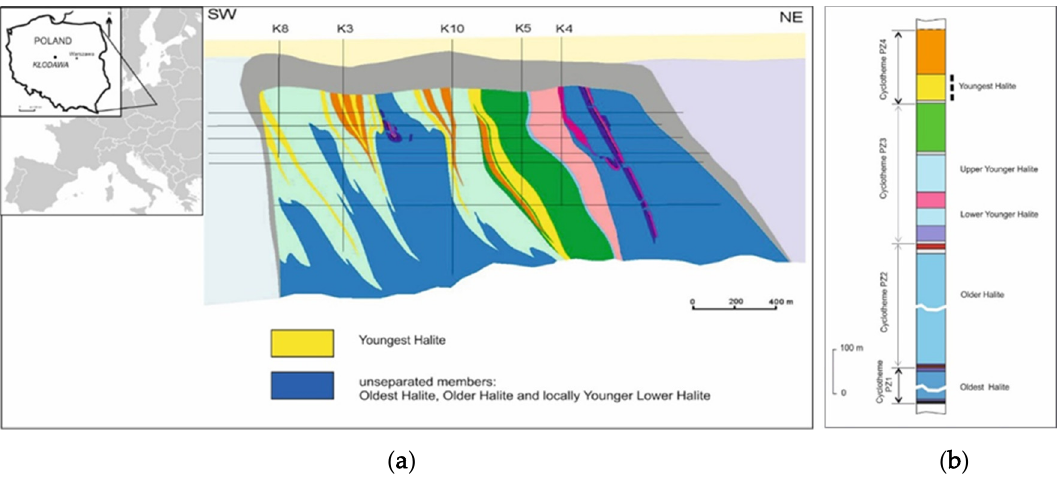
Figure 5. ( a ) Cross-section of the upper part of the Kłodawa salt dome, Central Poland (after Burliga 2004 [27], simplified by the authors); ( b ) stratigraphic profile of the Upper Permian (Zechstein) in the Kłodawa salt dome with matched Youngest Halite stratigraphic level (after Wachowiak 2010, [28], simplified and modified by the authors).